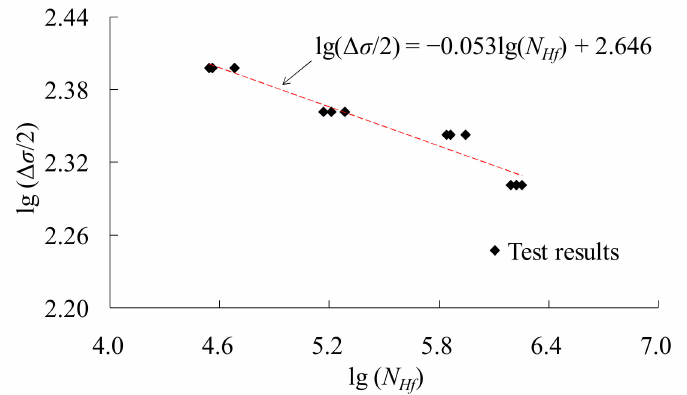
Figure 3. High cycle fatigue test results and the fitting